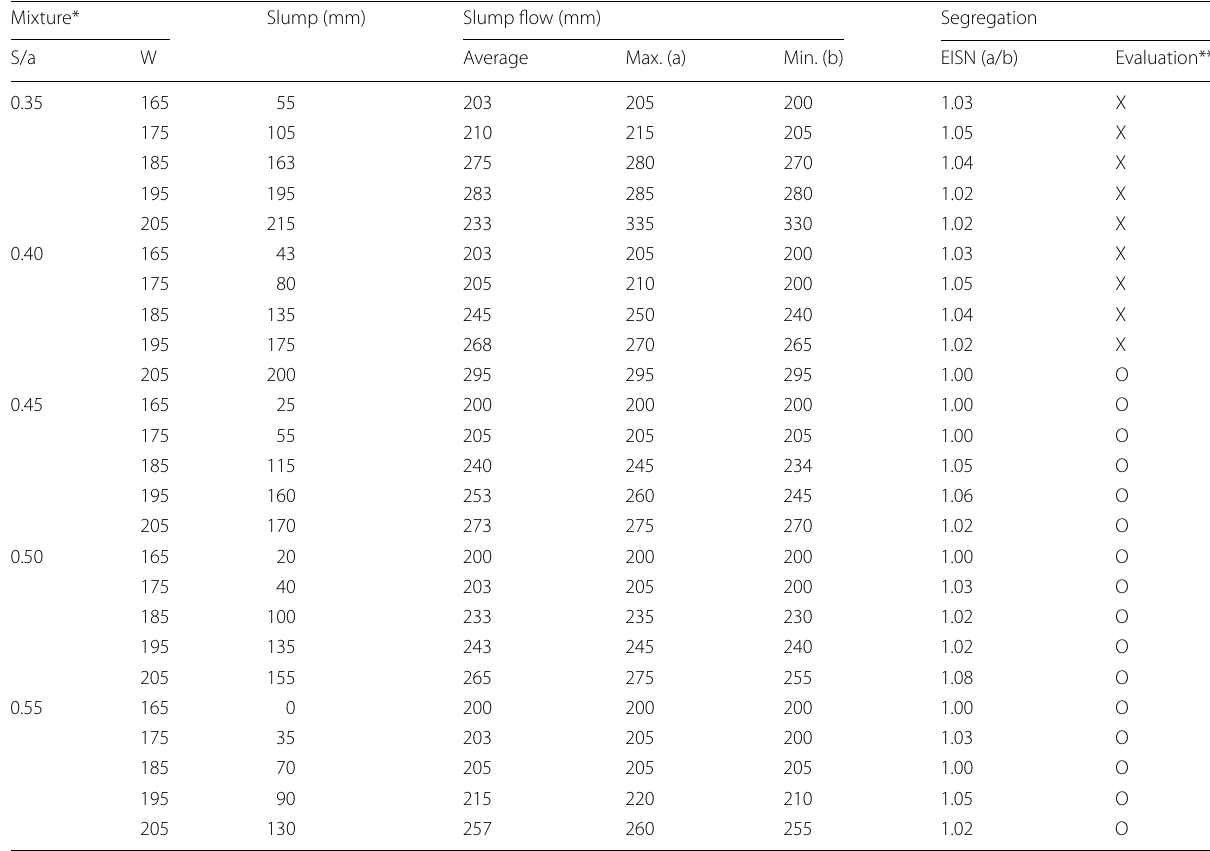
Table 5 Slump and slump flow test results and EISN calculation data of high‑strength concrete